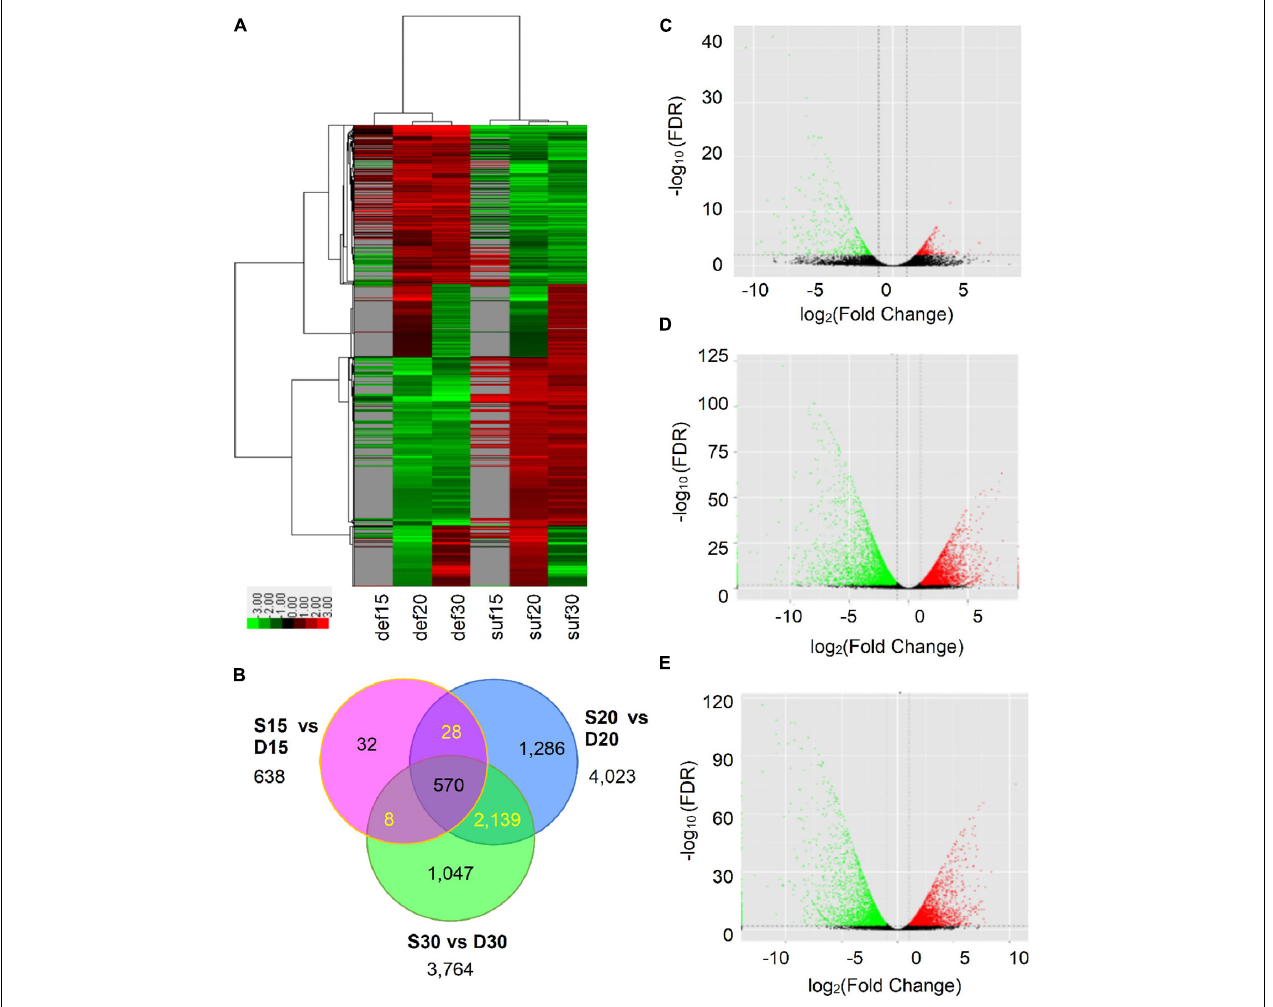
FIGURE 2 | Transcriptional changes in peanut embryos responded to calcium deficiency. (A) Expression profiles of the DEGs response to calcium deficiency were analyzed and clustered by average linkage method. Expression level was calculated using log 2 (FPKM + 1). Red indicates up-regulated genes, green indicates down-regulated genes and gray indicates no expression data. (B) The distribution of differentially expressed transcripts. (C) The volcano plot of DEGs at 15 DAP. (D) The volcano plot of DEGs at 20 DAP. (E) The volcano plot of DEGs at 30 DAP. FDR in panels (C–E) means false discovery